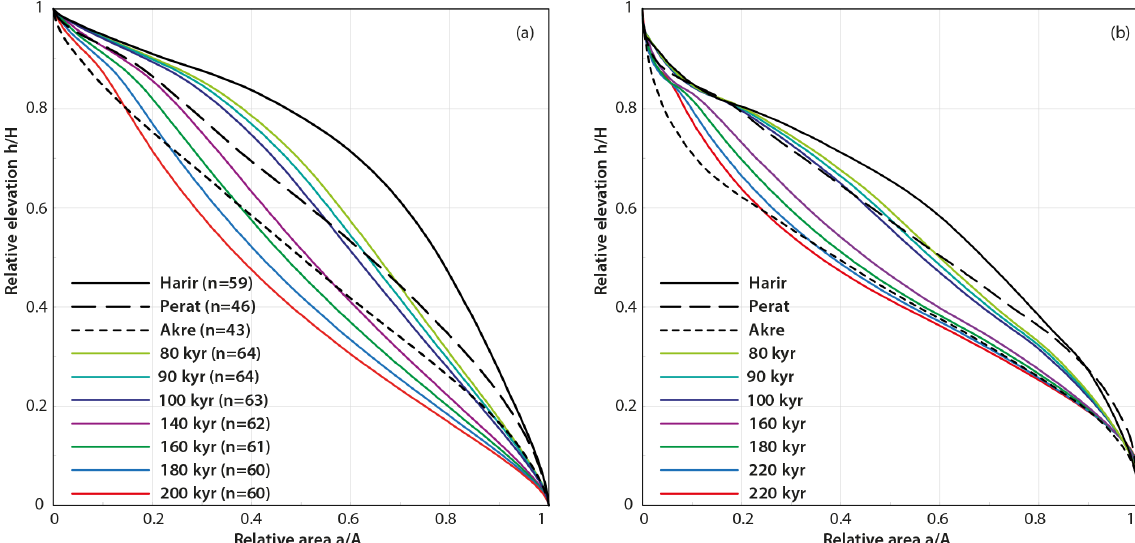
Figure 9. Hypsometric curves of the studied anticlines and those of the evolved Harir landscape from the model for different time spans. (a) The curves were calculated using the total weighted mean for drainage basin within each anticline, indicating that the evolved landscapes after 100 and 160kyr are the closest ones to the present-day Perat and Akre anticlines, respectively. n is the number of basins used in the calculation of the hypsometric curve for each time; (b) the curves were calculated for the entire anticline, indicating that the evolved landscapes after 80 and 200kyr are the closest ones to the present-day Perat and Akre anticlines, respectively.